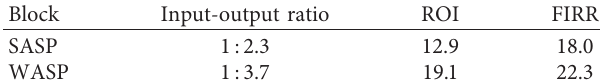
Table 20: Economical benefit